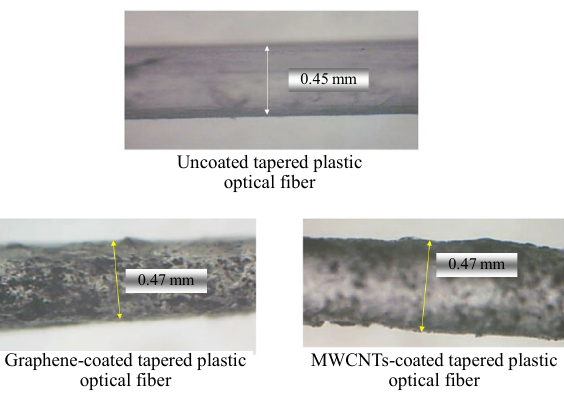
Fig. 2 Microscopic images of the tapered POF coated with graphene and MWCNTs in comparison with the tapered POF without the coating